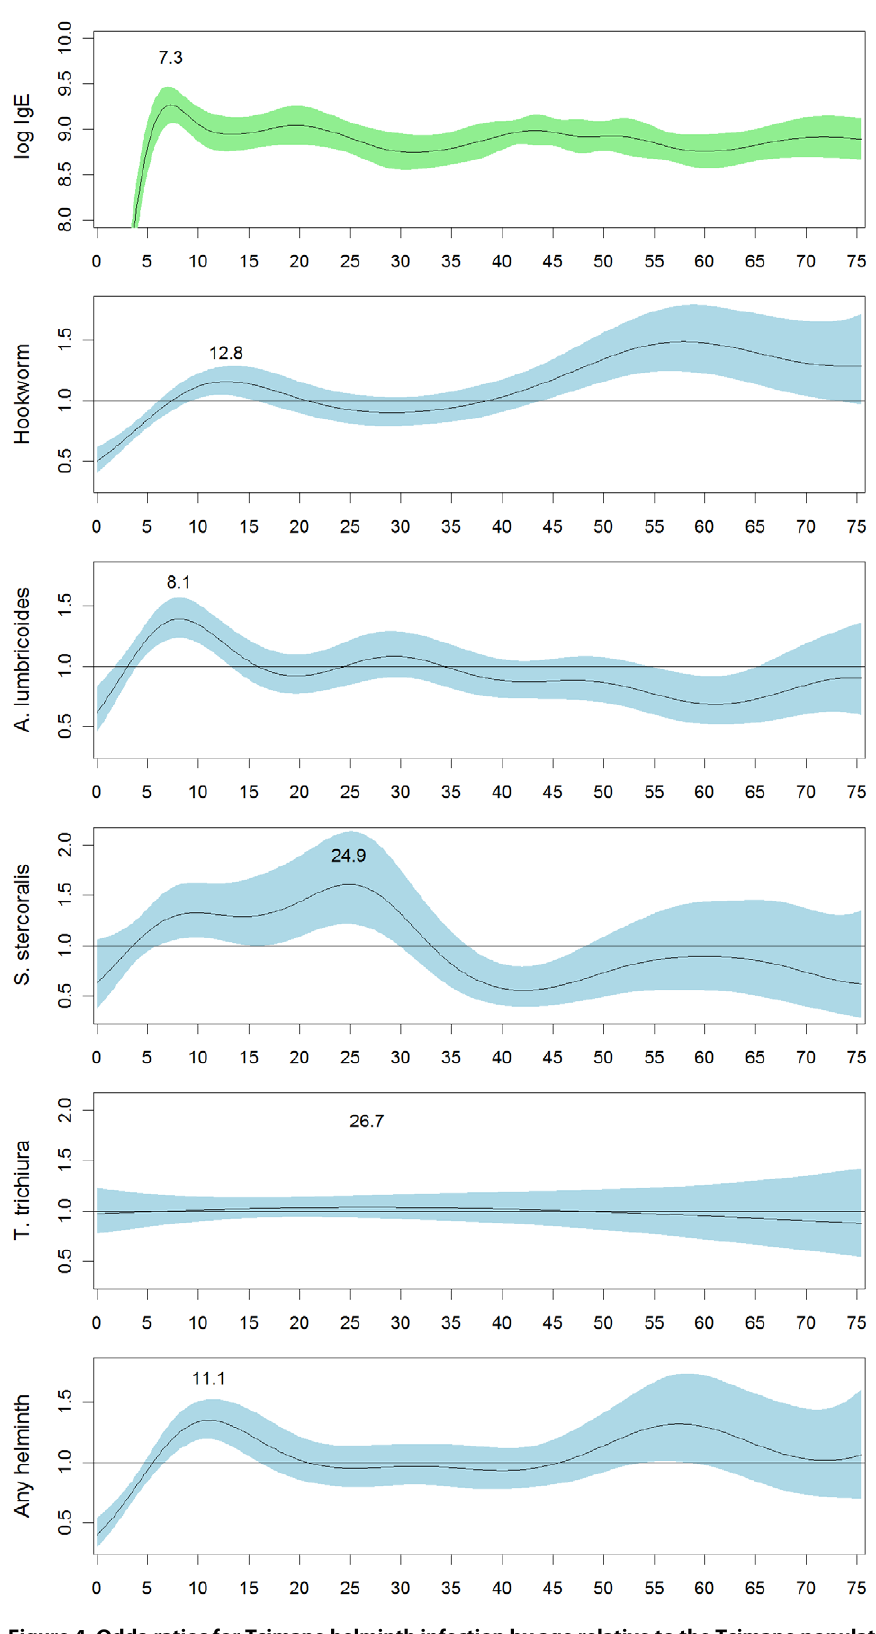
Figure 4. Odds-ratios for Tsimane helminth infection by age relative to the Tsimane population as a whole. Odds-ratios were estimated with generalized additive models with a binomial logit link function. Shading shows the 95% confidence interval for the odds-ratio. All age functions were significant at p , 0.001, except the age function for T. trichiura , which was non-significant.